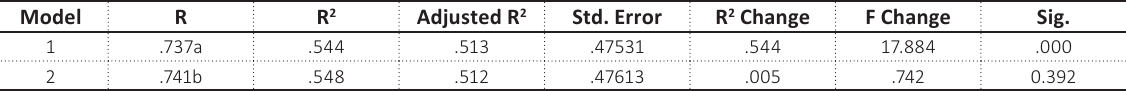
Table 5. Influence of Maslow’s hierarchy of needs on mumpreneurial intentions (education level)